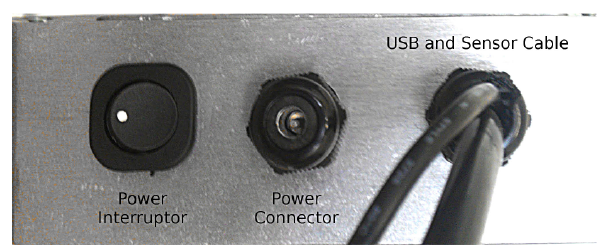
Figure 9. Case front.